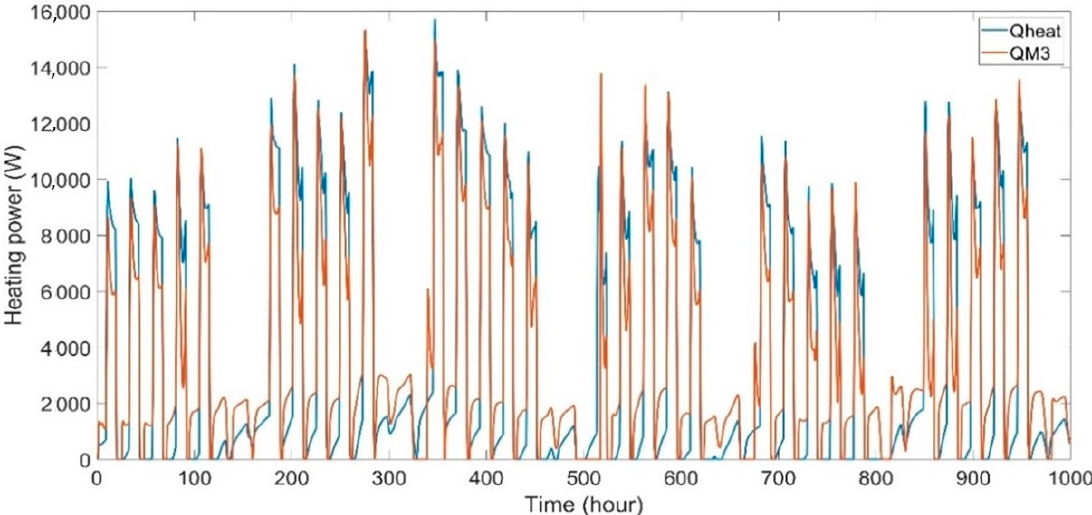
Figure 11. Calculated heat demand from model M3 and the simulated results from TRNSYS.